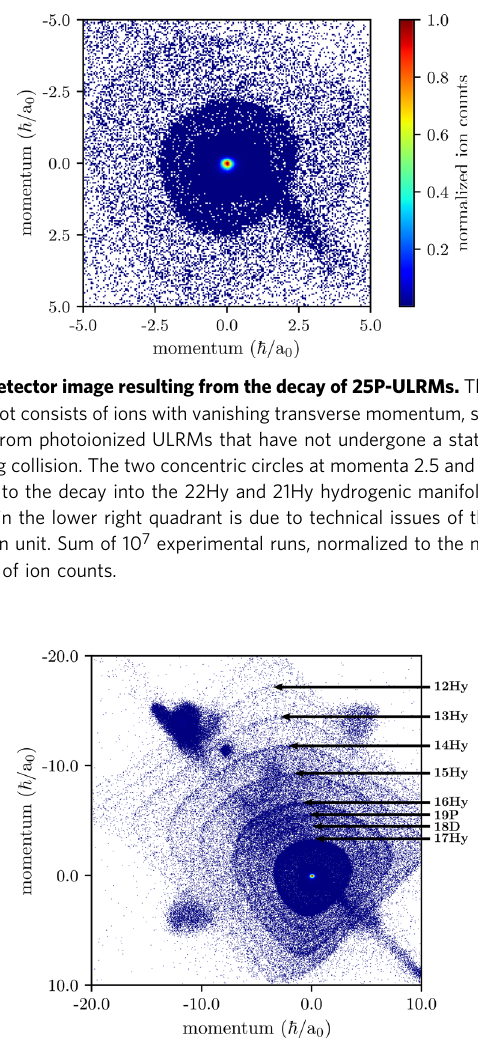
Fig. 4 Full detector image for state-changing collisions of 20P-ULRMs. Final states with principal quantum numbers down to n = 12 are clearly visible. In addition, the decay to the 18D- and 19P-state can be observed, indicating the presence of low- l fi nal states. The color code is the same as in Fig. 3. Deviations from the circular shape are due to design-related imperfections, causing a repulsion of the ions along the two diagonals. The artifacts in the corners of the detector plane are due to technical issues of the detection